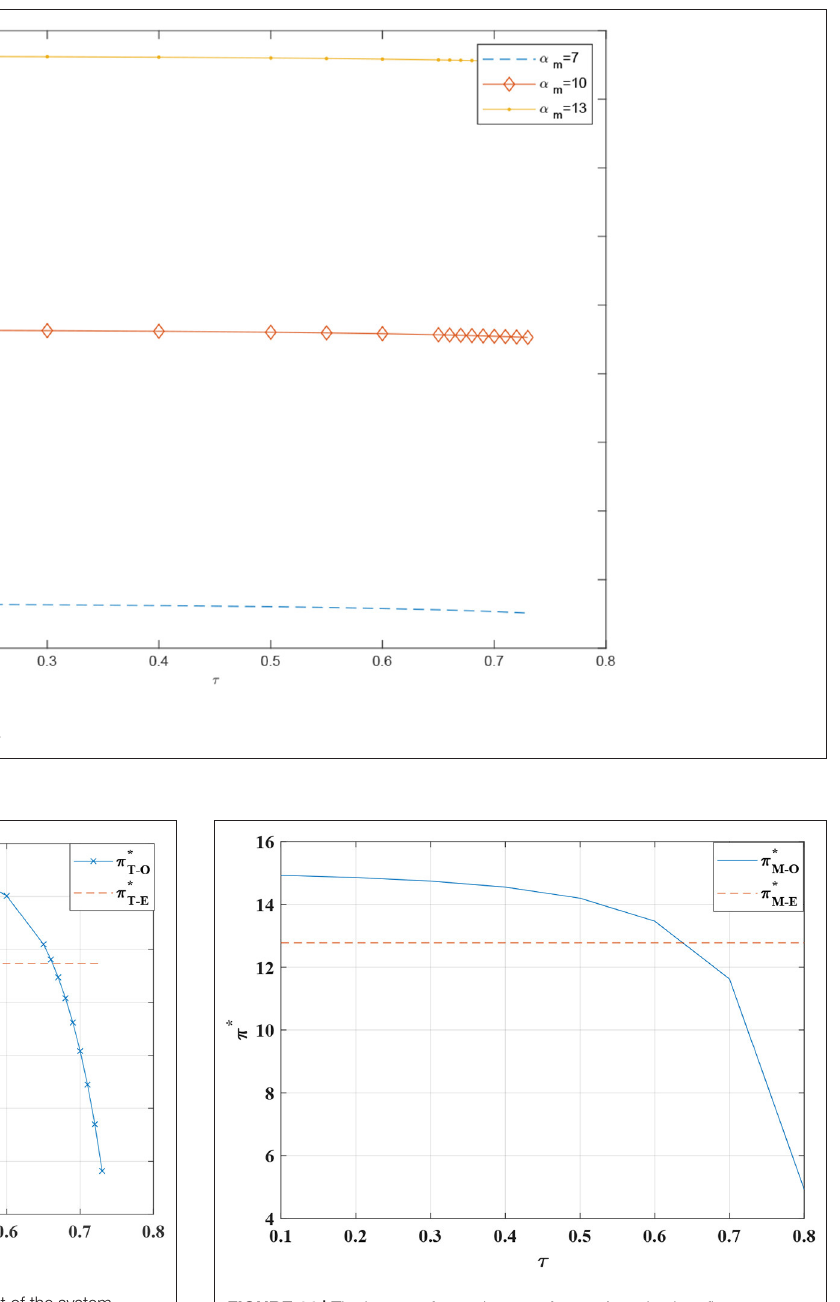
FIGURE 13 | The impact of τ on the overall optimal profit of the system. FIGURE 14 | The impact of τ on the manufacturer’s optimal